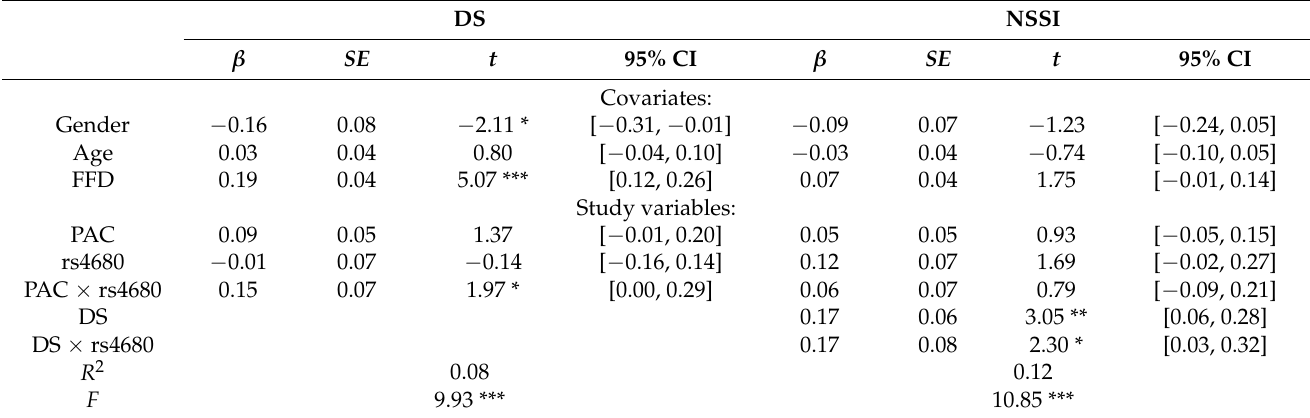
Table 3. Testing for the moderating role of rs4680 polymorphism on the indirect relationship between parent-adolescent conflict and adolescent NSSI via depressive symptoms.